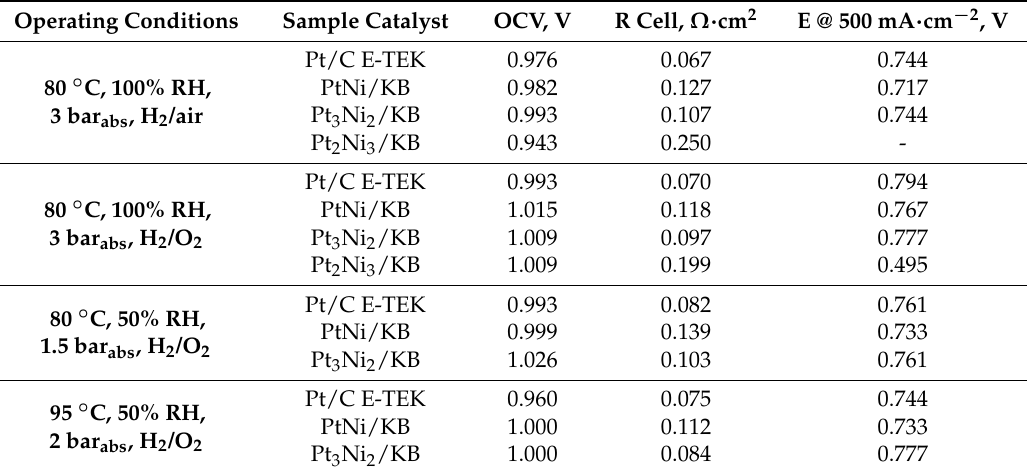
Table 3. Summary of the fuel cell